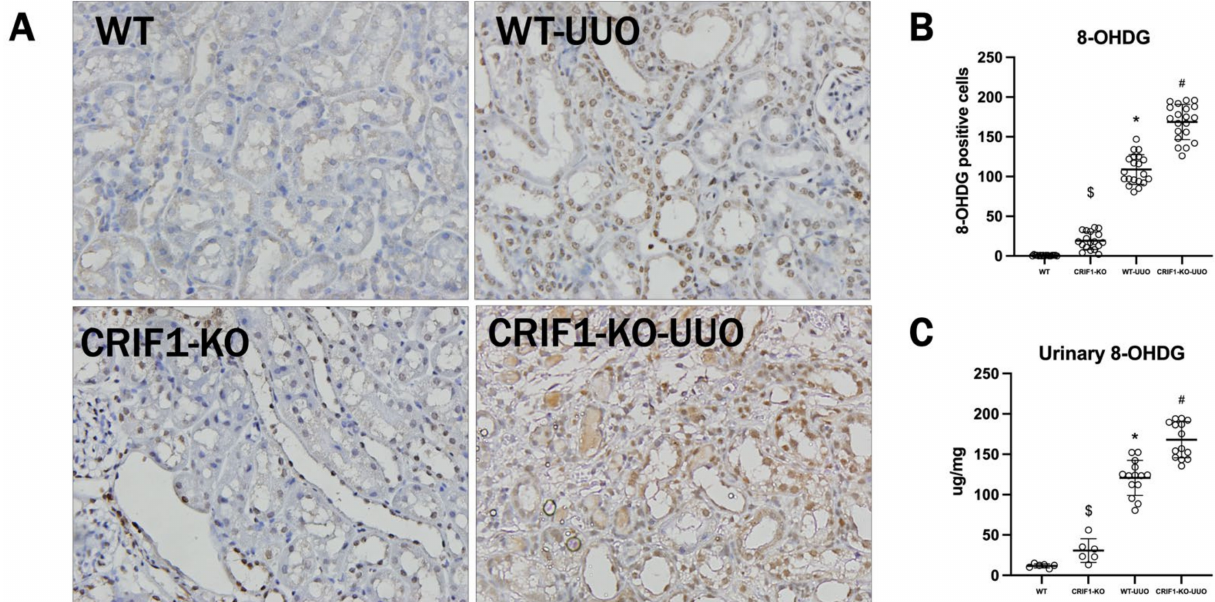
Figure 8. Photos of immunohistochemistry of 8-hydroxydeoxyguanosine (8-OHDG) ( A ). CR6-interacting factor-1 knockout (CRIF1-KO) mice had a significant increase in 8-OHDG-positive cell recruitment compared with wild-type (WT) mice. CRIF1- KO-unilateral ureteral obstruction (UUO) kidneys showed higher recruitment of 8-OHDG-positive cells than WT-UUO kidneys ( B ). Urinary 8-OHDG excretion in WT and CRIF1-KO mice ( C ). CRIF1-KO mice had a significant increase in urinary 8-OHDG compared with WT mice. CRIF1-KO-UUO kidneys showed higher urinary 8-OHDG than WT-UUO kidneys. $ p < 0.05, WT-sham vs. CRIF1-KO-sham; * p < 0.05, WT-sham vs. WT-UUO; # p < 0.05, WT-UUO vs.